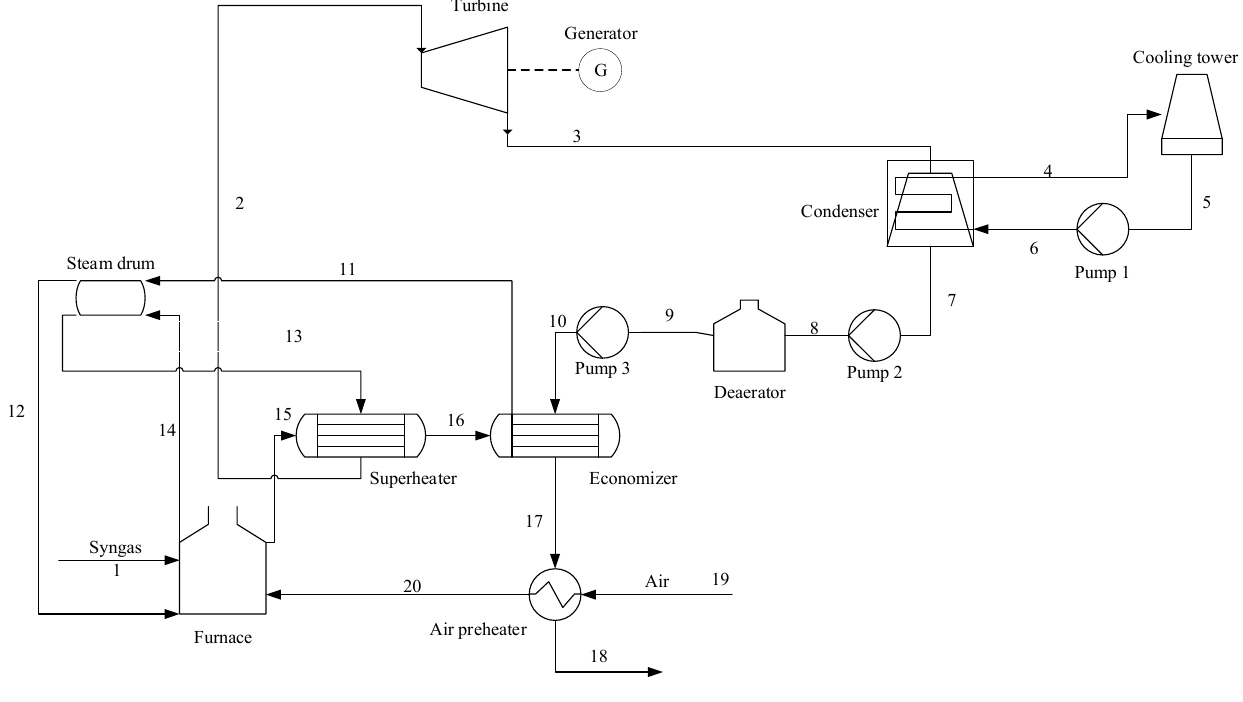
Figure 2. Rankine cycle schematic.